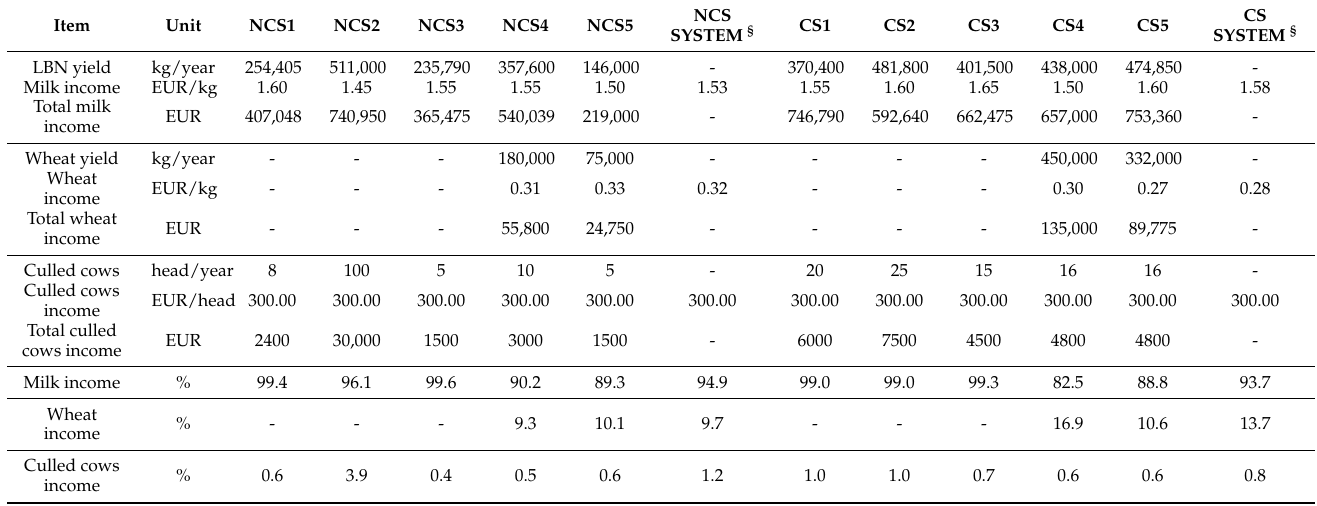
Table A1. Yields and economic incomes (%) derived from milk, wheat grain, and culled cows